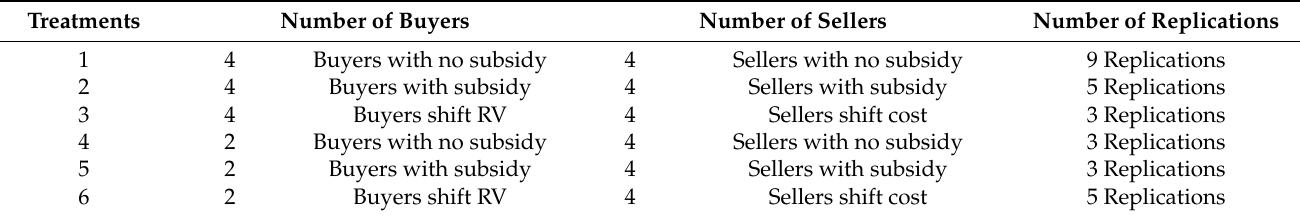
Table 1. Treatments conducted in the